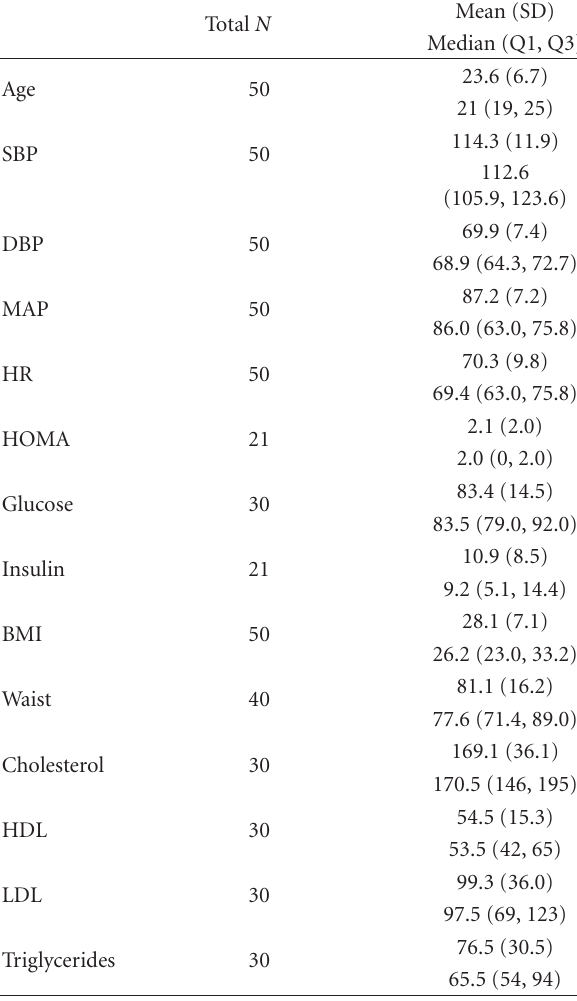
Table 1: Participants traditional cardiovascular risk factors. Table 2: Cardiovascular reactivity responses to cold pressor and